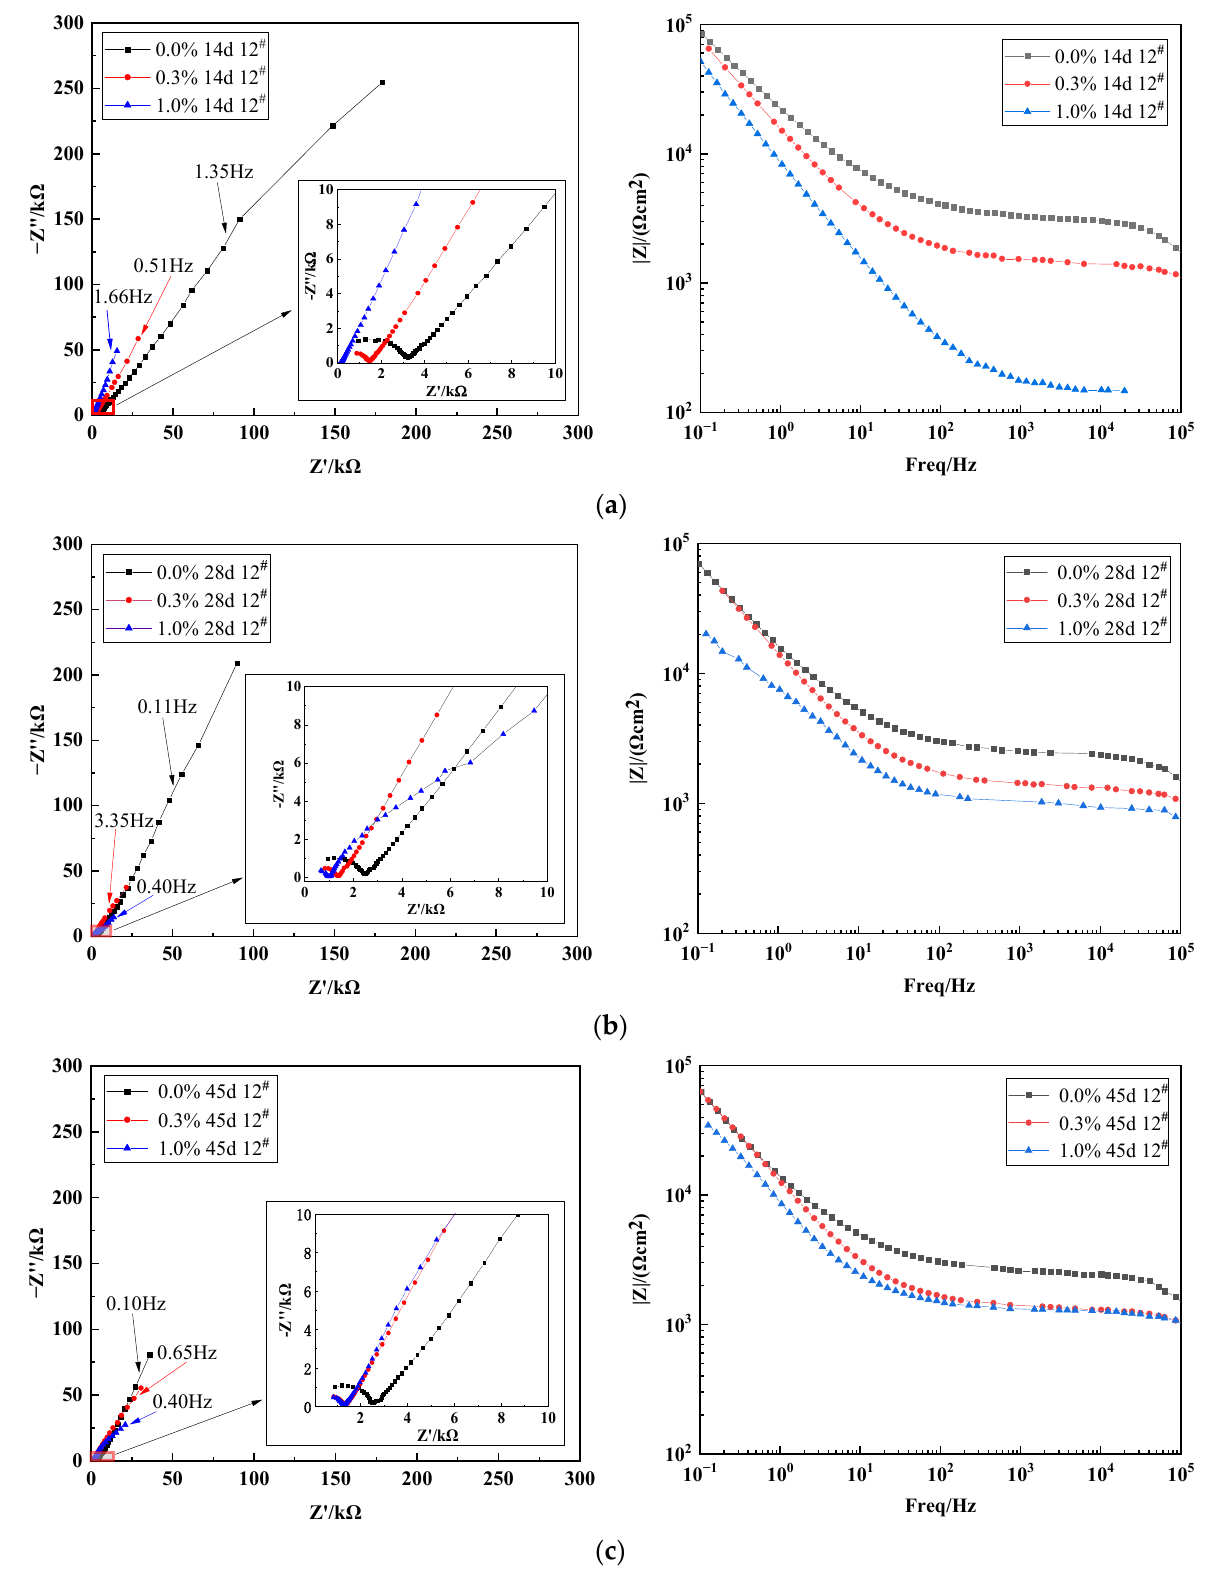
Figure 10. Nyquist and Bode plots of X70 steel at 12 # height of soil column: ( a ) 14 days, ( b ) 28 days, and ( c ) 45 days.